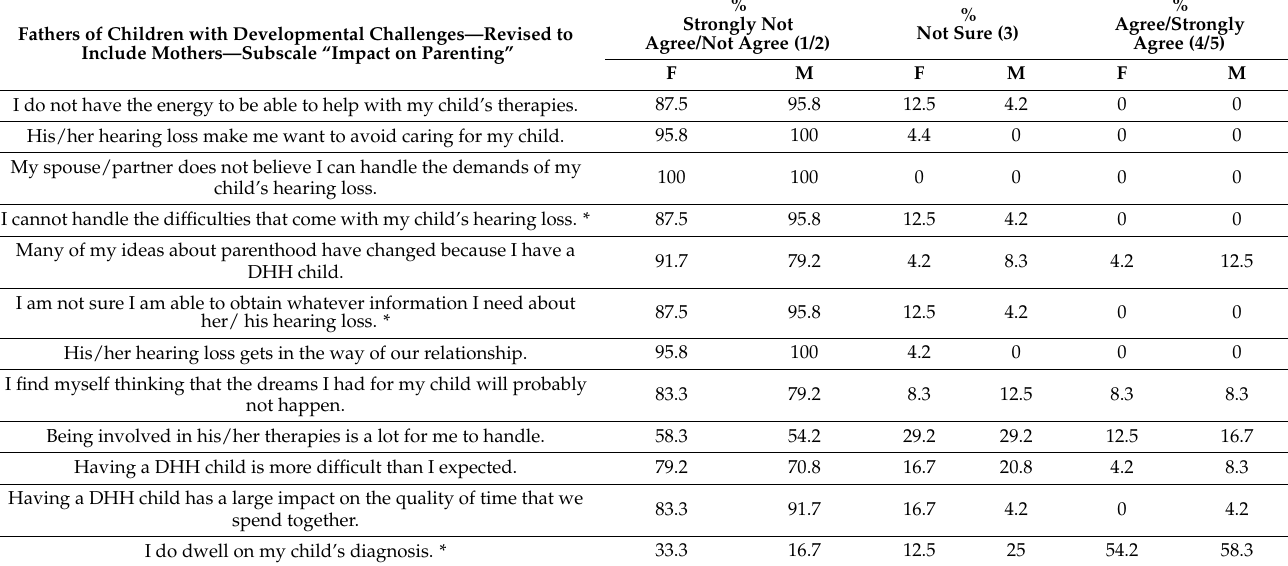
Table 4. Impact of child’s deafness on parents’